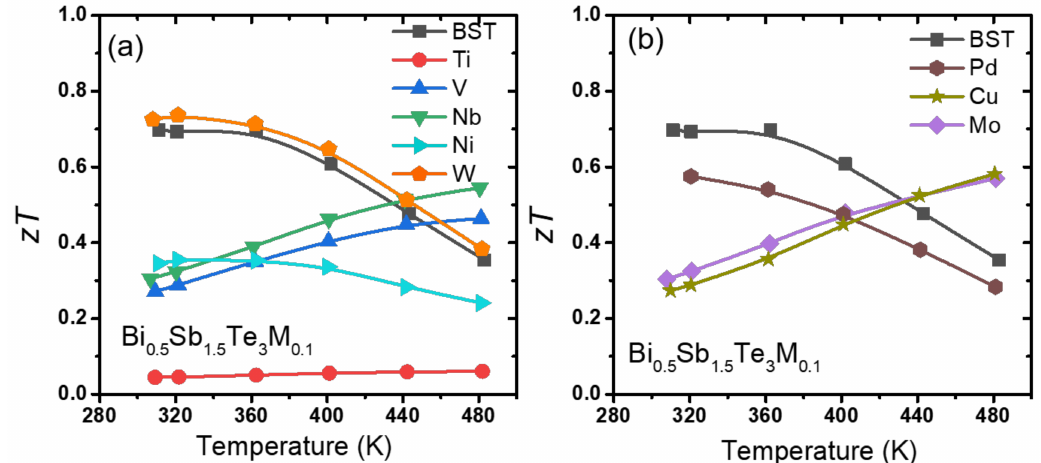
Figure 7. Figure of merit zT of ( a ) Bi 0.5 Sb 1.5 Te 3 M 0.1 ( M = Ti, V, Nb, Mo and W) and ( b ) Bi 0.5 Sb 1.5 Te 3 M 0.1 ( M = Ni, Pd and